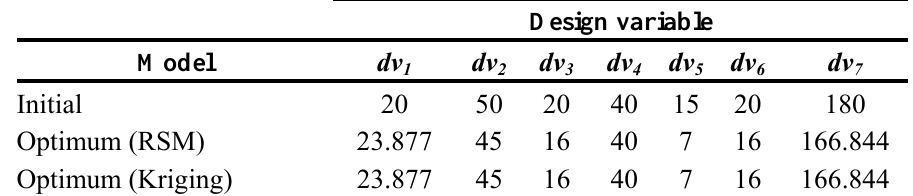
Table 4. Optimum β and correlation parameters for kriging models (N